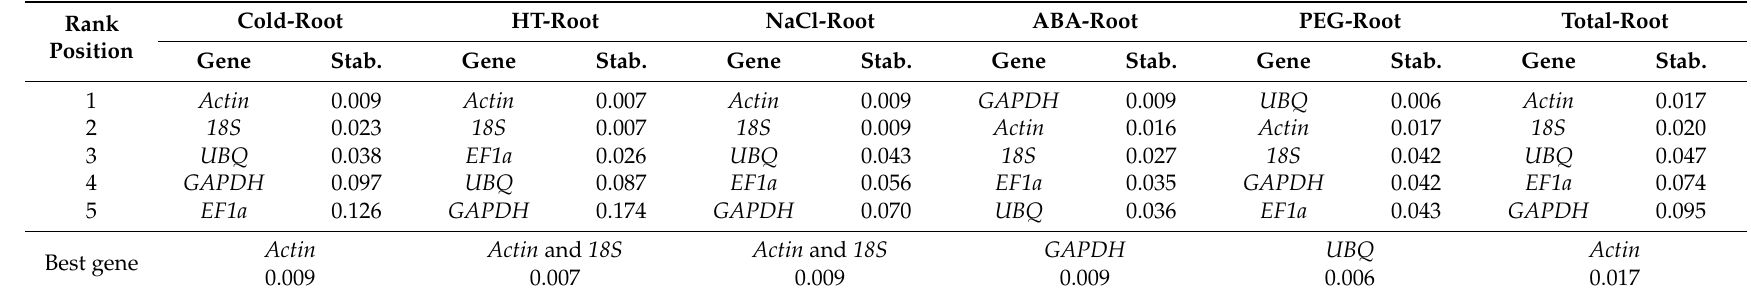
Table 1. Expression stability values and ranking of HKGs in Chinese fir root as calculated by the NormFinder.